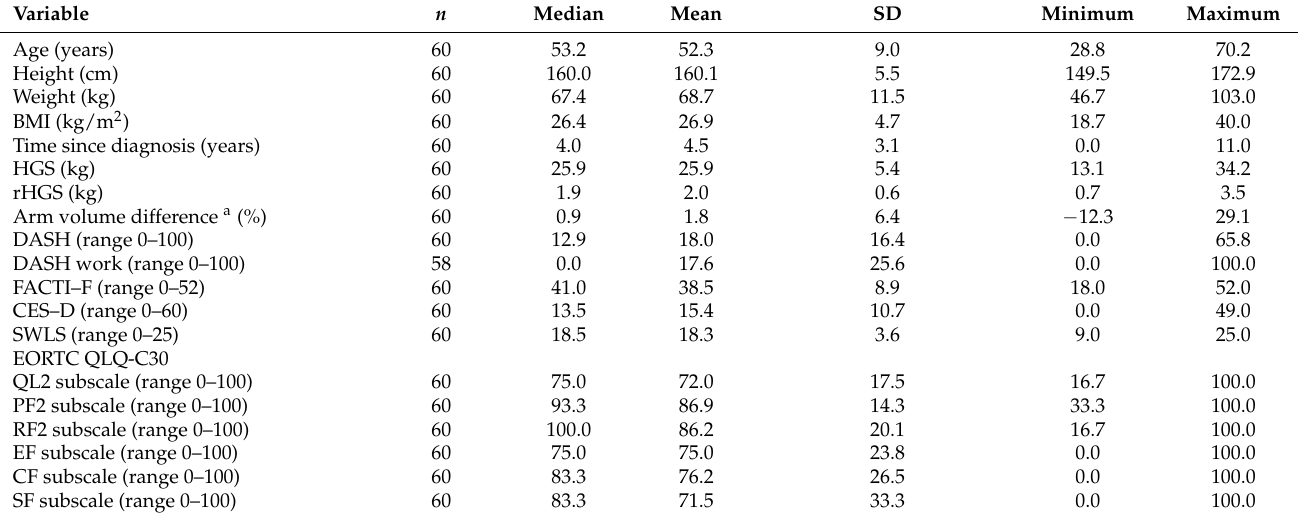
Table 1. Descriptive characteristics of the study